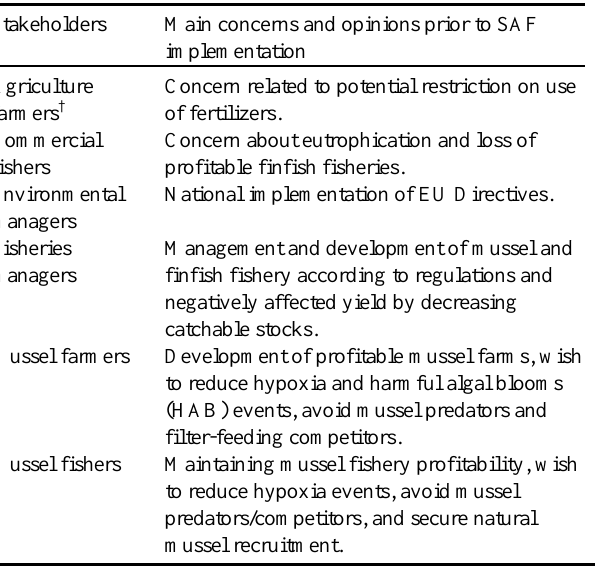
Table 3. The participating Limfjord stakeholders and their main concerns prior to System Approach Framework (SAF)